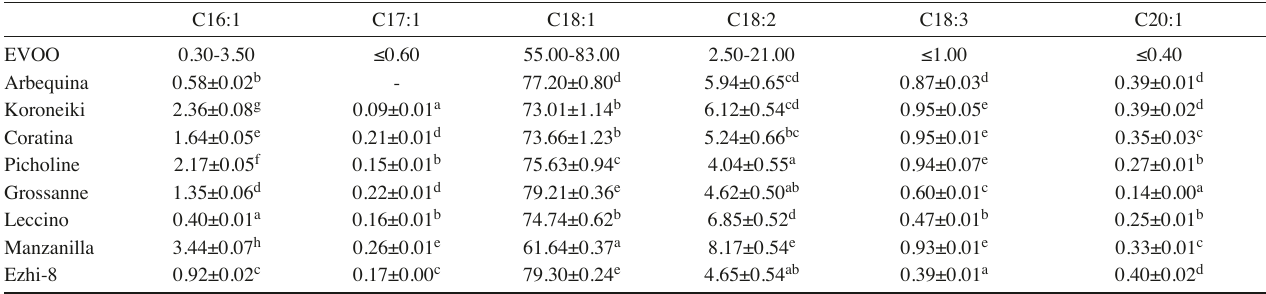
Tab. 4: Unsaturated fatty acid composition of olive oil (%)